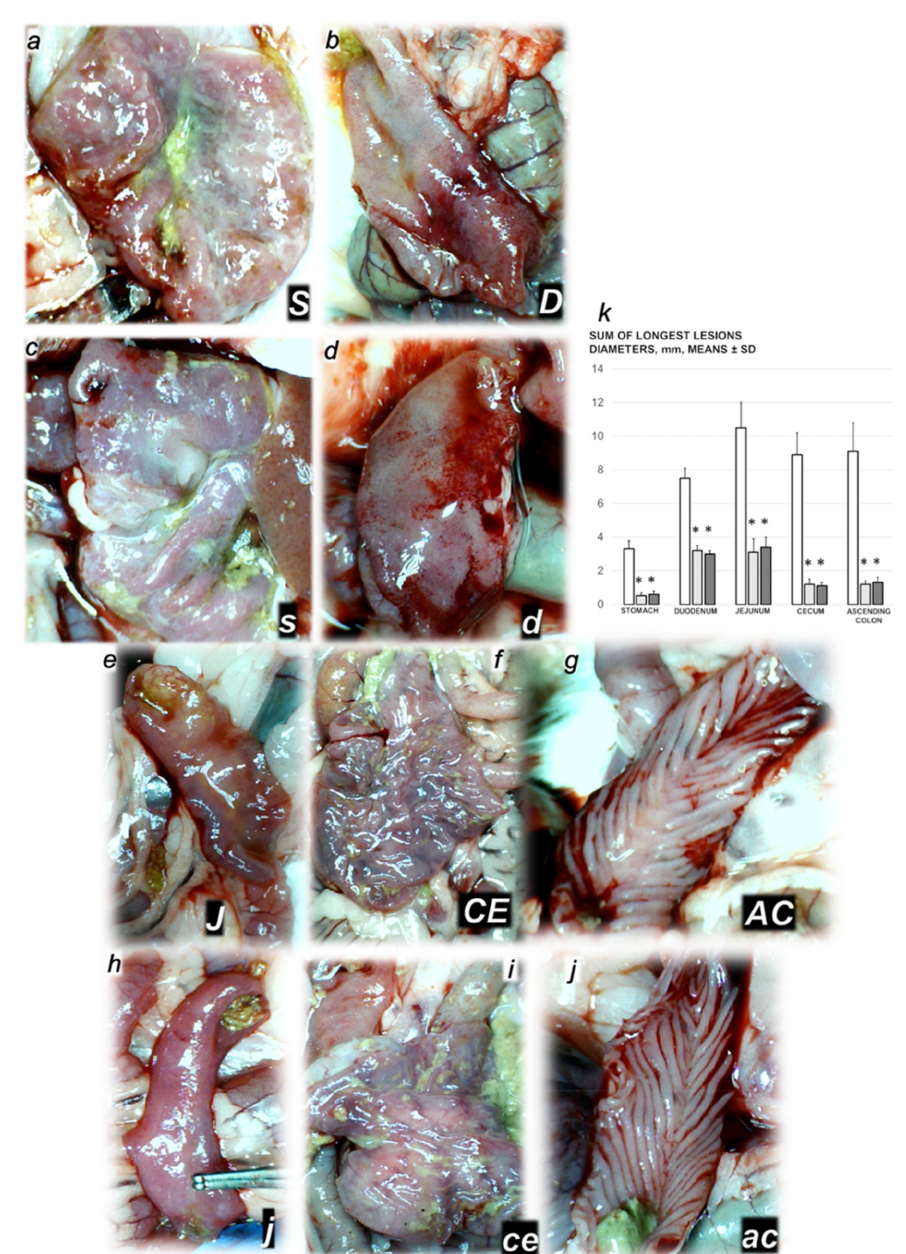
Figure 5. Illustrative gross gastrointestinal lesions presentation ( a – j, black letters, lesions specifically indicated with white letters, small letters (control), capitals (BPC 157) as follows: stomach ( S , s ) ( a , c ) ( S (BPC 157 ( a ), s (control ( b )); duodenum ( D , d ) ( b , d ) ( D (BPC 157 ( b ), d (control ( d )); jejunum ( e , h ) ( J (BPC 157) ( e ), j (controls) ( h )); cecum ( CE (BPC 157) ( f ), ce (controls) ( i )); ascending colon ( AC (BPC 157) ( g ), ac (controls) ( j )). Lesion progression ( c , d , h – j ) or more preserved mucosa ( a , b , e – g ) in the gastrointestinal tract of the rats with the occluded end of the superior mesenteric vein, at 30 min after they had received saline therapy (small letters) or BPC 157 therapy (capitals). ( k ) Mucosal gastrointestinal lesions (sum of the longest lesions diameters, mm, means ± SD) at the end of the 30 min period following medication (BPC 157 10 µ g/kg (light gray bars), 10 ng/kg (dark gray bars); saline 5 mL/kg (white bars)) given intraperitoneally. Six rats/group/interval. * p < 0.05, at least, vs.